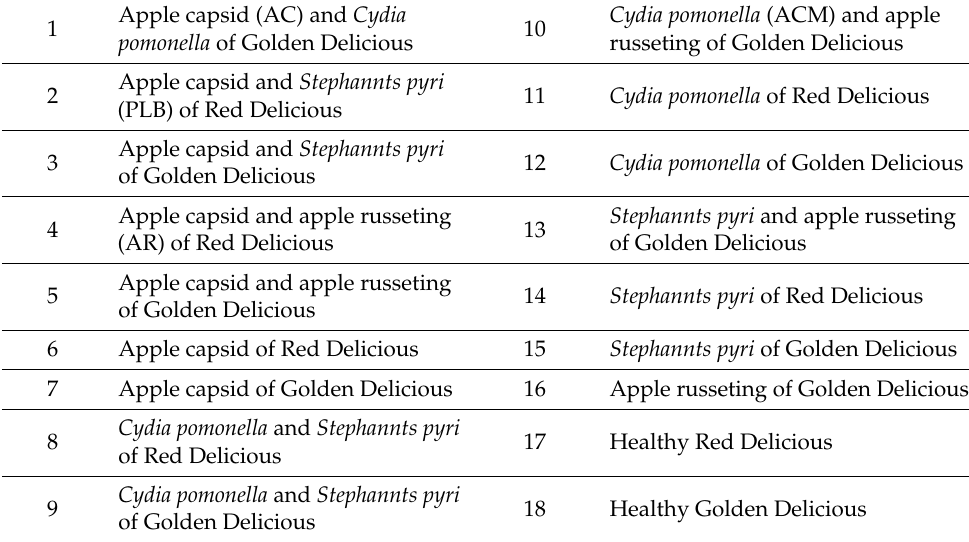
Table 1. Classification of healthy and diseased